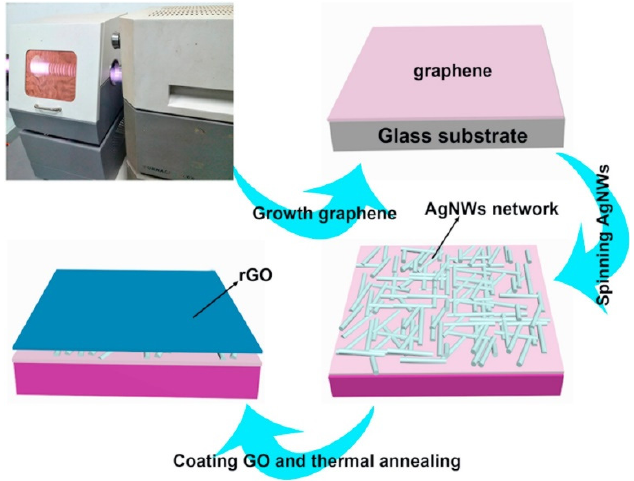
Figure 9. Schematic of the fabrication process of the G/Ag NWs/G sandwich film on a glass substrate [50].